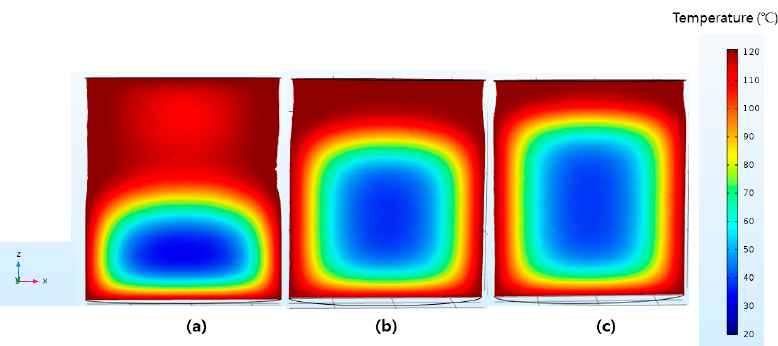
Figure 3. Simulated temperature distribution resulting from heat transfer simulation in BF samples of different amounts of ( a ) 100 g, ( b ) 150 g, and ( c ) 200 g in stand ‐ up pouches.